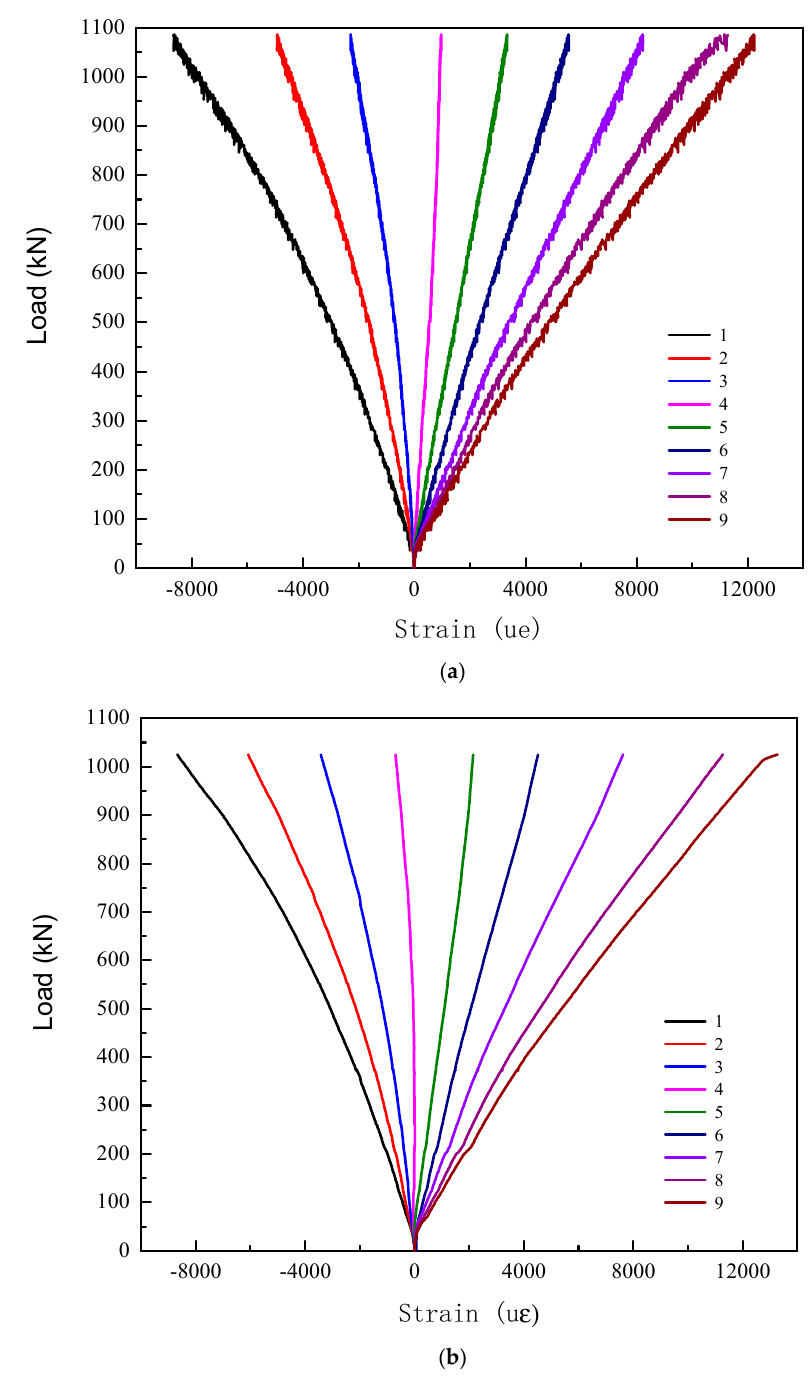
Figure 8. Load-strain curves of specimen series R2000-300-12. ( a ) Specimen R2000-300-12A ( b ) Specimen R2000-300-12B.